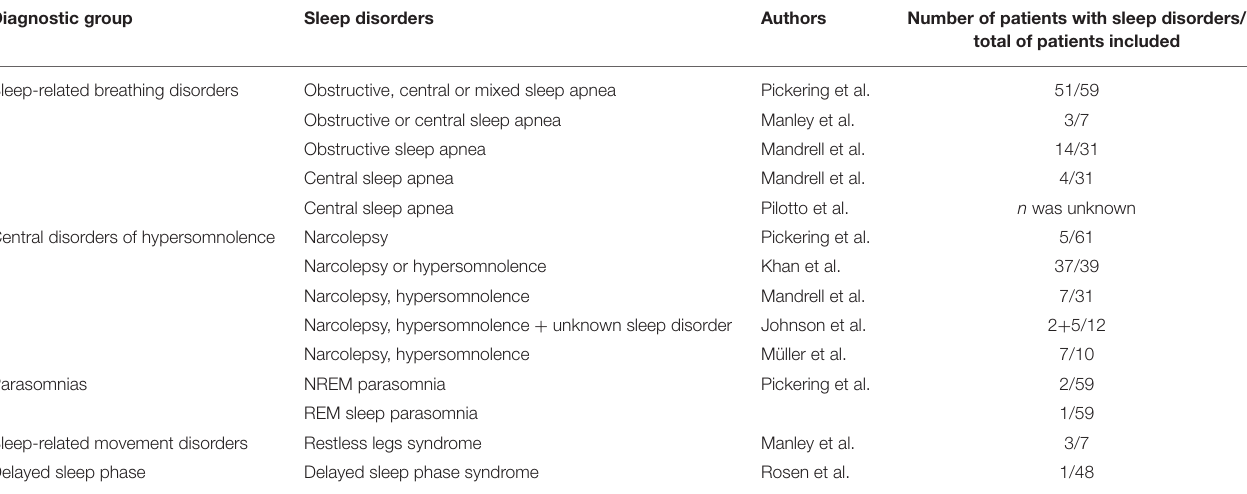
TABLE 4 | Sleep disorders classified according to International Classification of Sleep Disorders, Third edition. Diagnostic